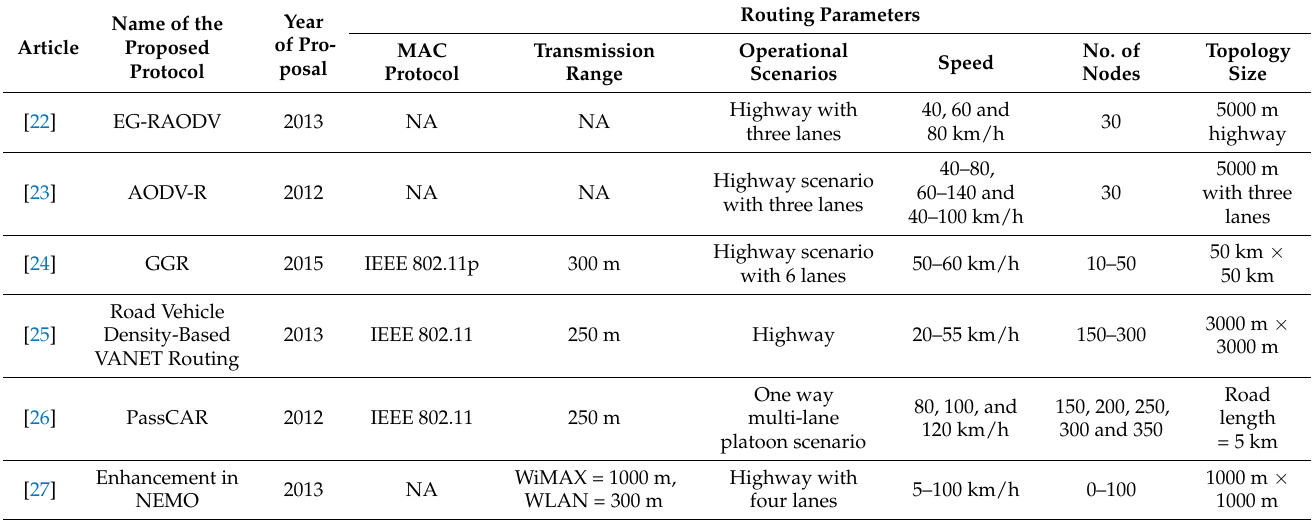
Table 2. Routing parameters of highway scenario-based routing protocols.